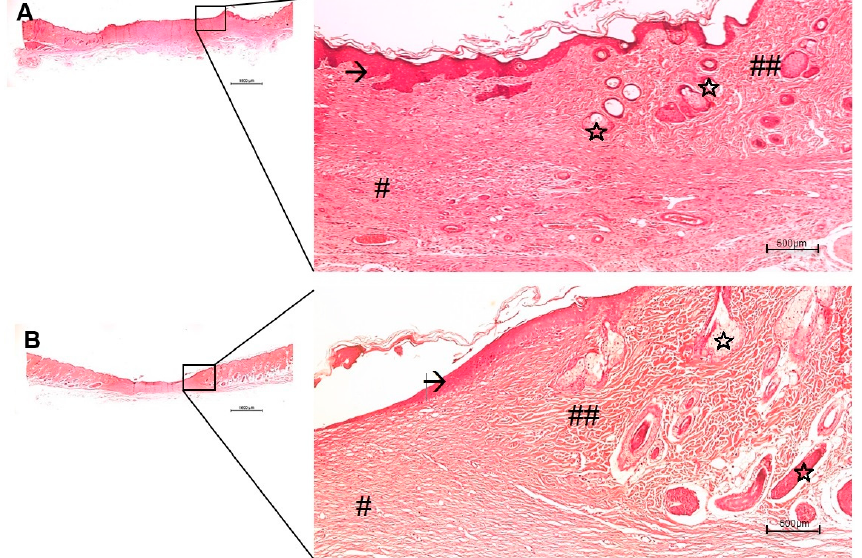
Figure 9. Histological images of the skin wound healing implanted with PVA-AgNP/col-HA/hMSC, after 14 ( A ) and 28 ( B ) days. The right images are higher magnification areas from the entire lesion site depicted at left. ( ￫ ) early epidermis (with crests in A); the new dermis (#) is less than the fibrous pattern (##) where pilous follicle structures were more richly identified (stars). Bars 1000 µm.